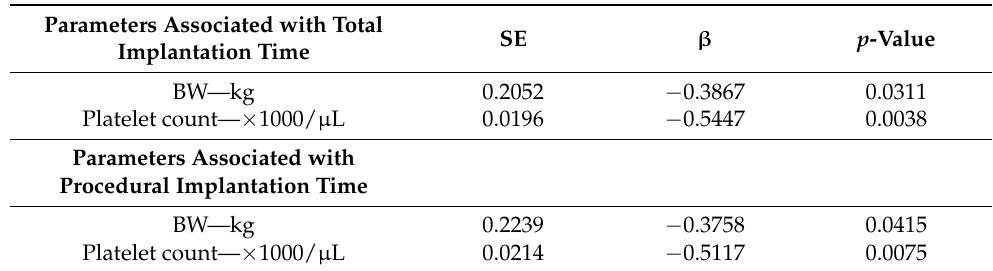
Table 2. Multiple linear regression of parameters associated with antegrade-tunneled HDC implanta- tion